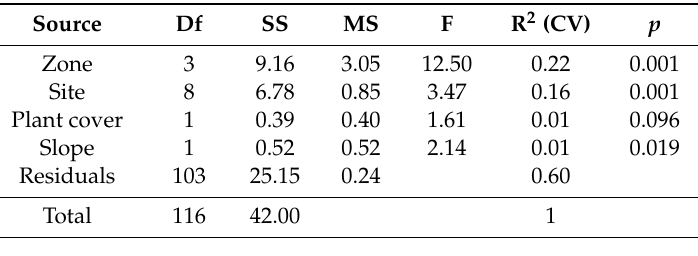
Table 3. Results of PERMANOVA analysis of species composition and environmental variables (zone, site, slope and plant cover). p < 0.05 are considered significant. Df = degrees of freedom; SS = sum of squares; MS = Mean squares; F = statistical; R 2 = coe ffi cient of